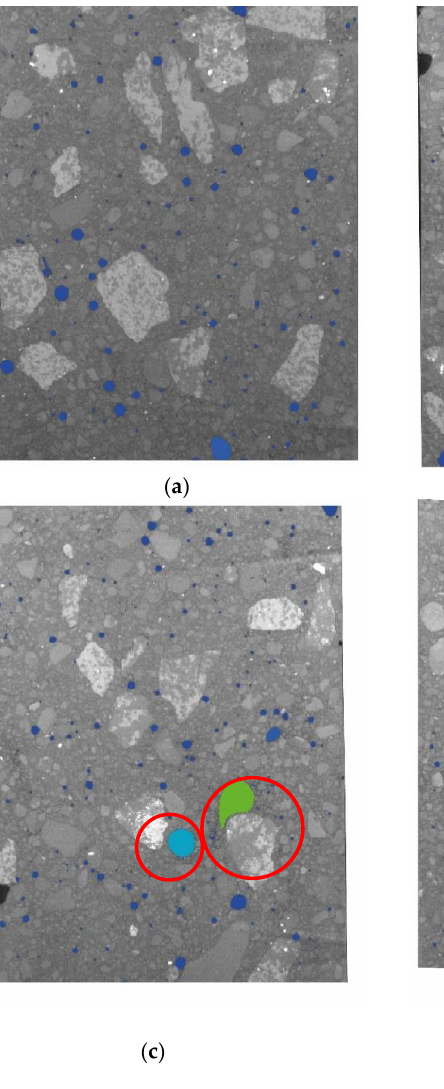
Figure 16. The CT porosity cross-section at the layer interface area, which can be found in more detail in Table 6, and localized large air bubbles entrapped near the coarse aggregate grains: ( a ) T5, ( b ) T10, ( c ) T15, and ( d ) T20. Table 6. Pore analysis of each specimen’s interface area.